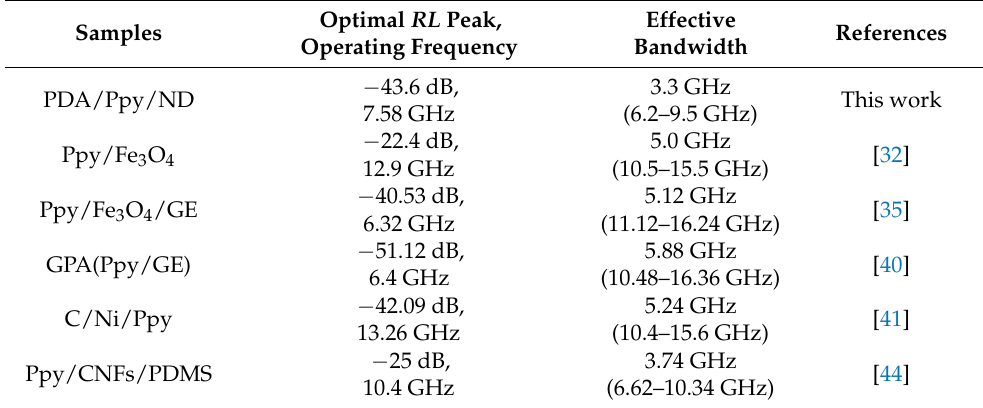
Table 1. The microwave-absorbing properties of some reported Ppy